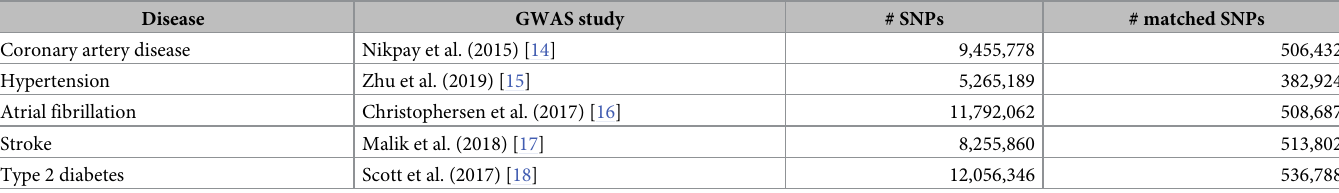
Table 3. External GWAS summary statistics used in our study.